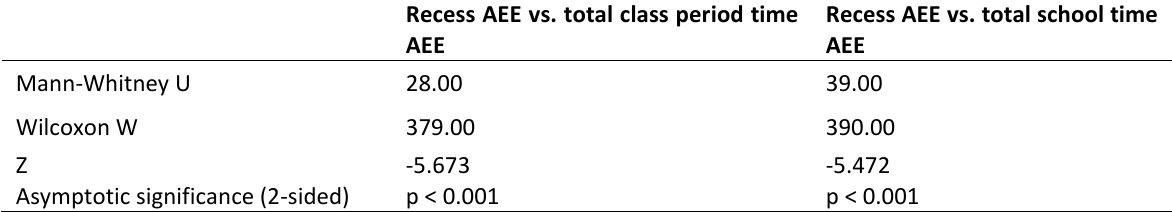
Table 4. Relationship between AEE of recess and total class period time/total school time (Mann-Whitney U test) Recess AEE vs. total class period time